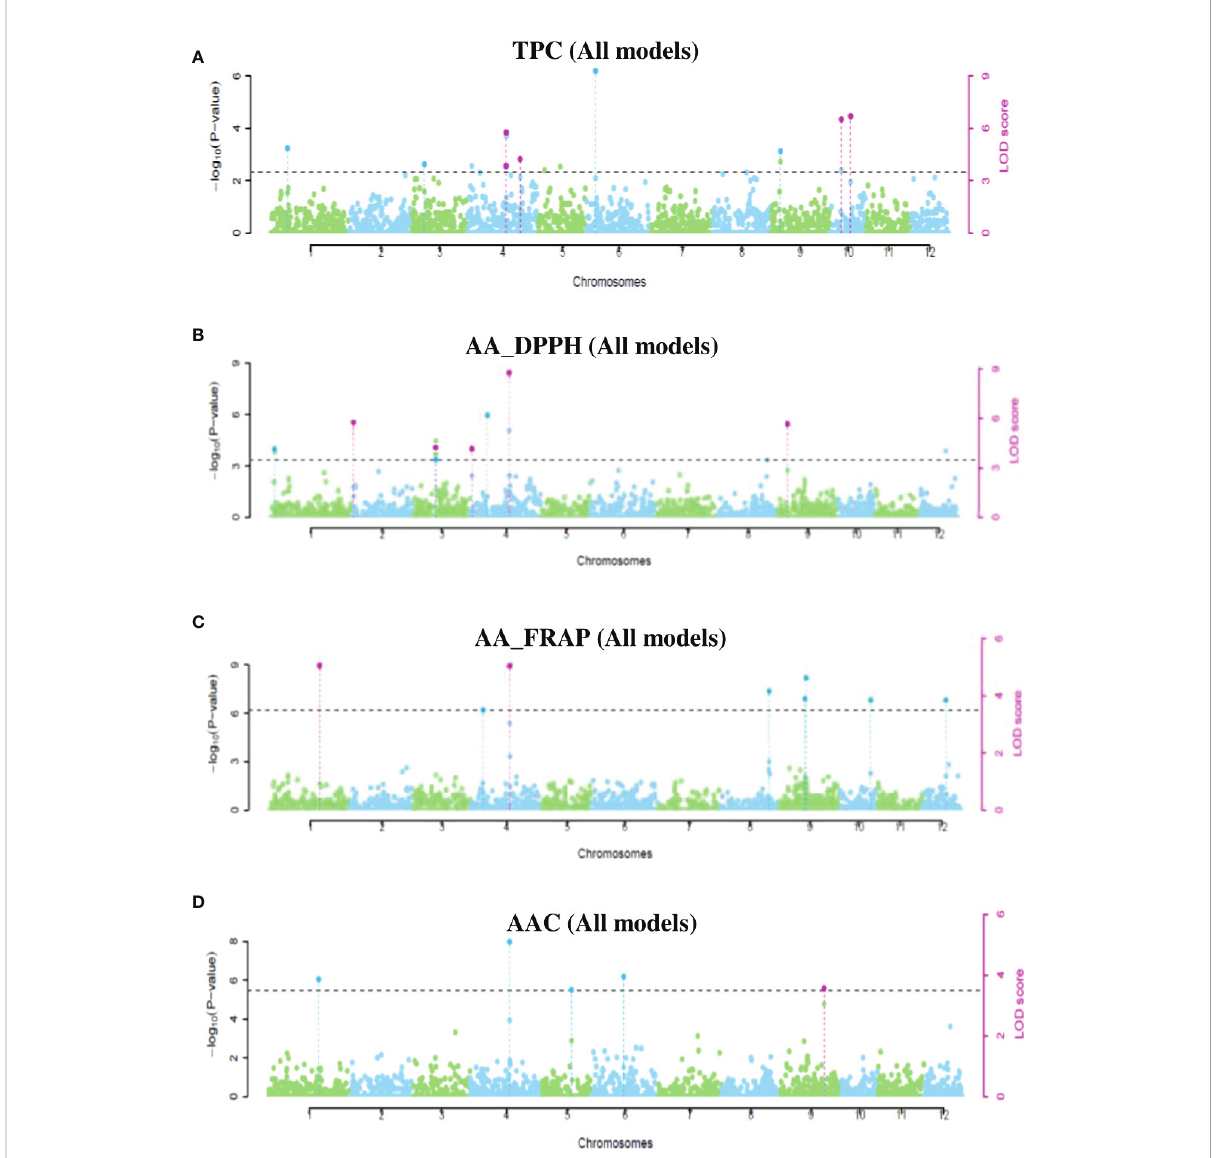
FIGURE 6 Manhattan plots showing signi fi cant QTNs for TPC (A) , AA_DPPH (B) , AA_FRAP (C) , and AAC (D) obtained using multi-locus GWAS methods in the mixed